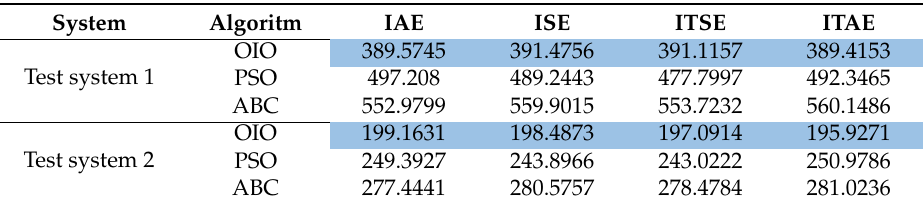
Table 6. Total computation time table in